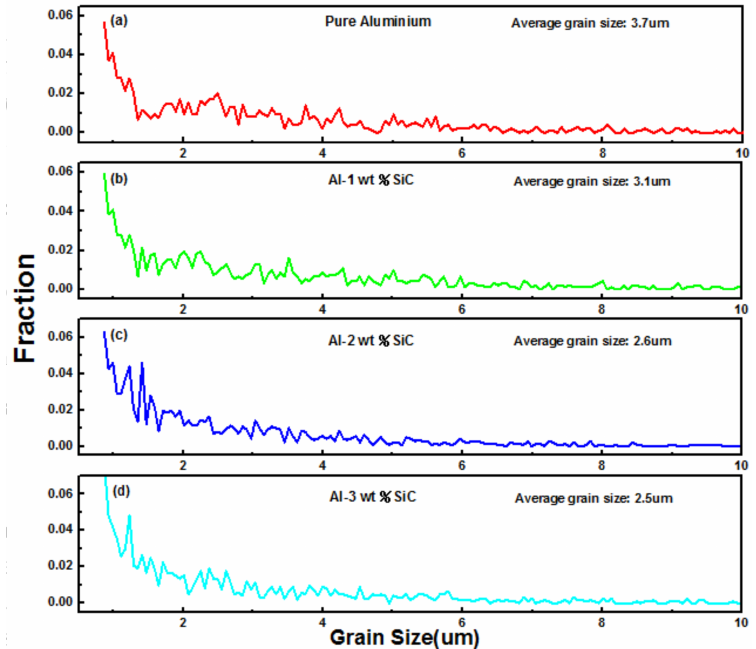
Figure 10. The grain-size distribution of composites ( a ) pure aluminium; ( b ) Al-1 wt % SiC; ( c ) Al-2 wt % SiC; ( d ) Al-3 wt %